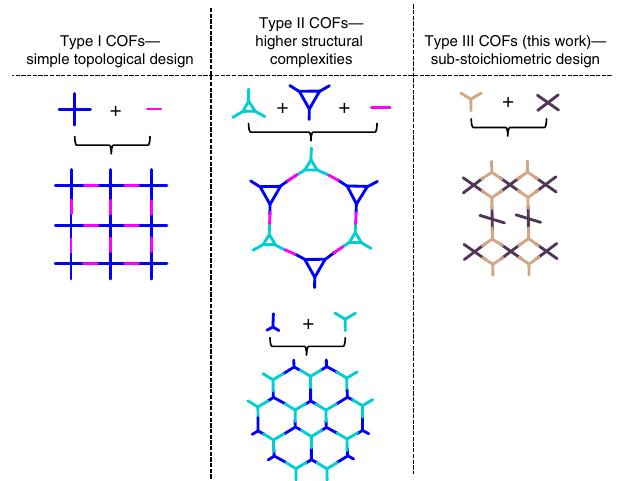
Fig. 1 Hierarchy of the evolution of structural complexity in